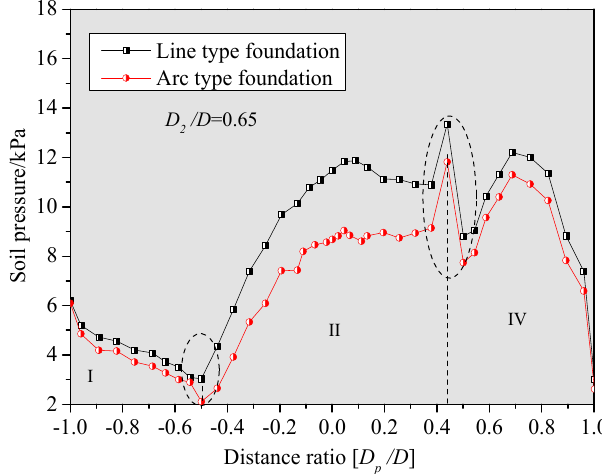
Figure 13. Top-cover soil pressure with ultimate load.